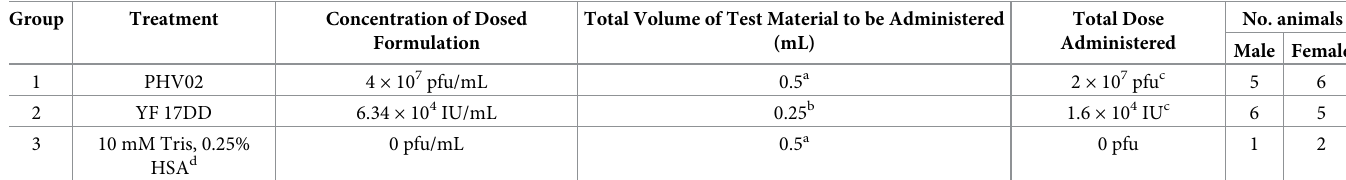
Table 1. Design of the Monkey Neurovirulence Test.